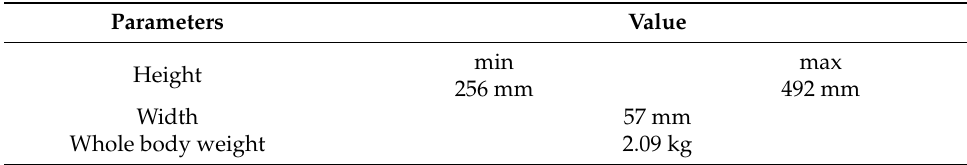
Table 1. Configuration parameters of the end effector.